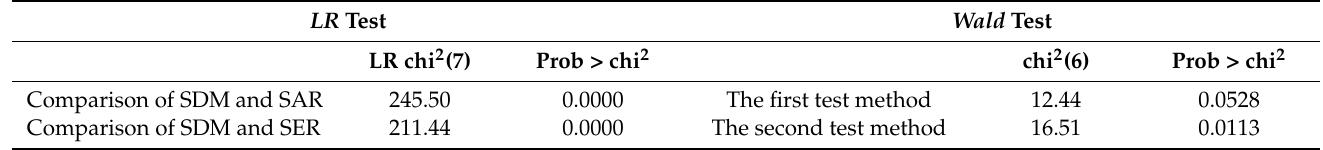
Table 3. Results of the likelihood ratio ( LR ) and Wald test.